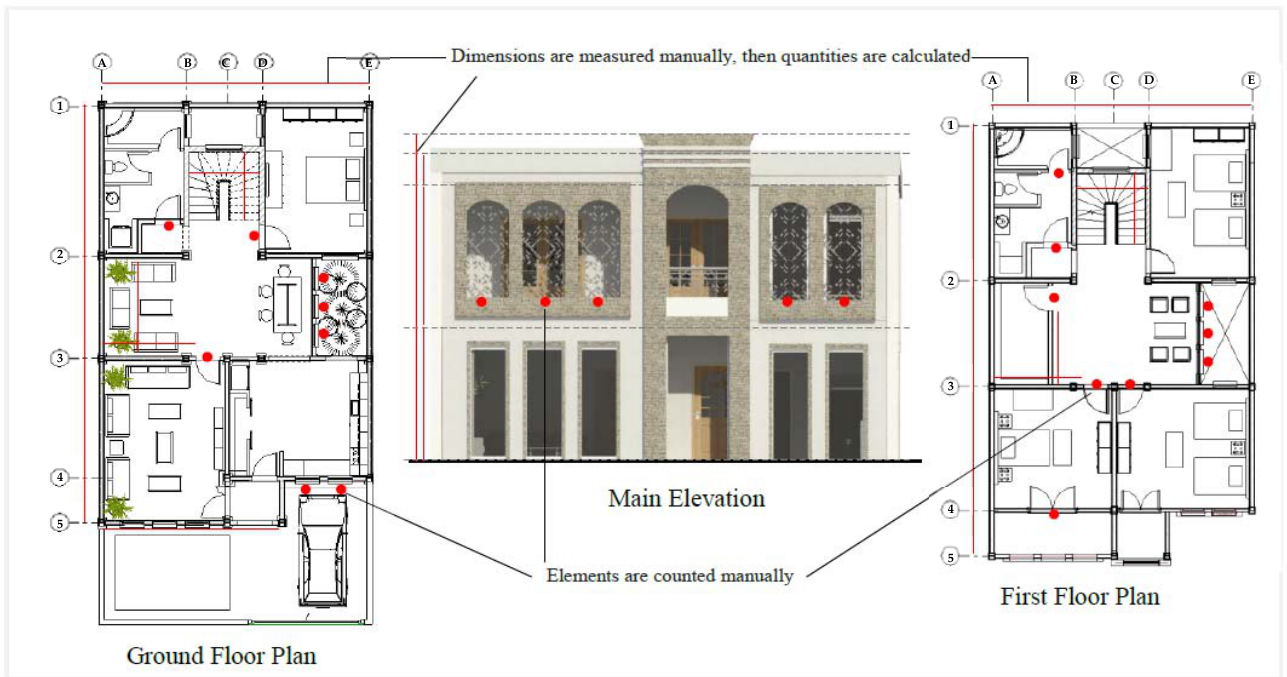
Figure 8. Manual Quantity Estimation Method (conventional cost estimation procedure).